Question: Looking at the figure, what chart type is it?
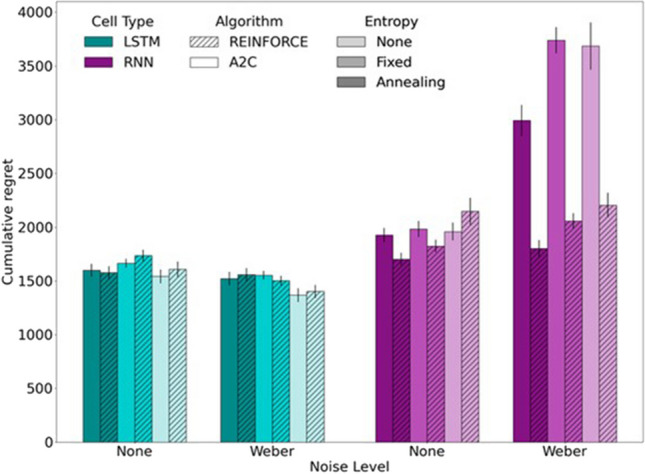
Answer: bar